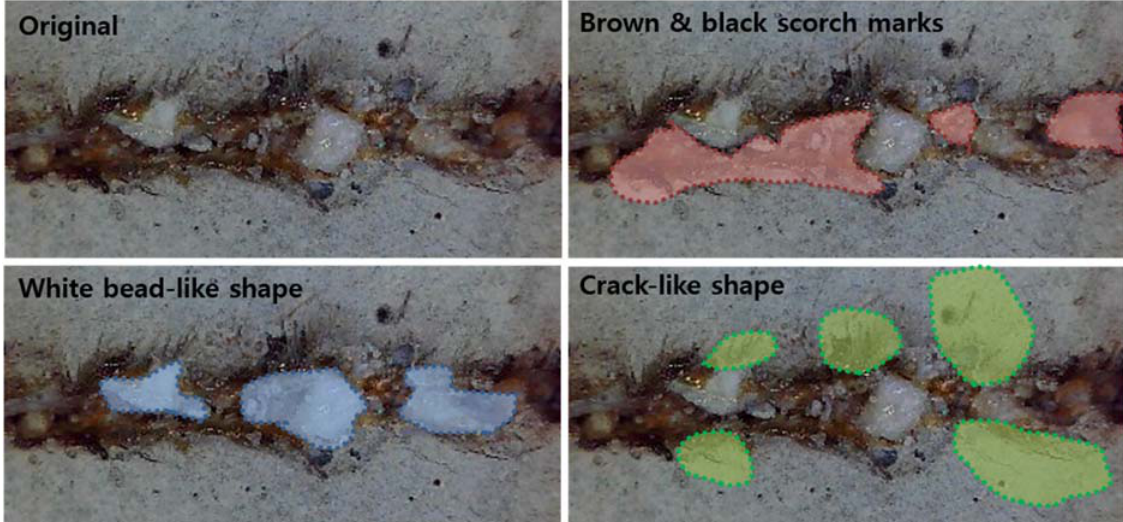
Figure 7. Three characteristics on the surface of the processed LM series: (1) white bead-like shape (Blue); (2) brown and black scorch mark (Red); (3) crack-like shape (Green).